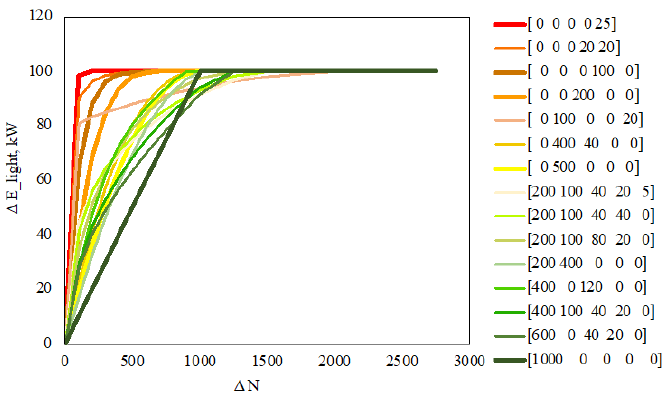
Figure 8. Influence of ∆N on ∆E light at different building layouts (baseN = 0).